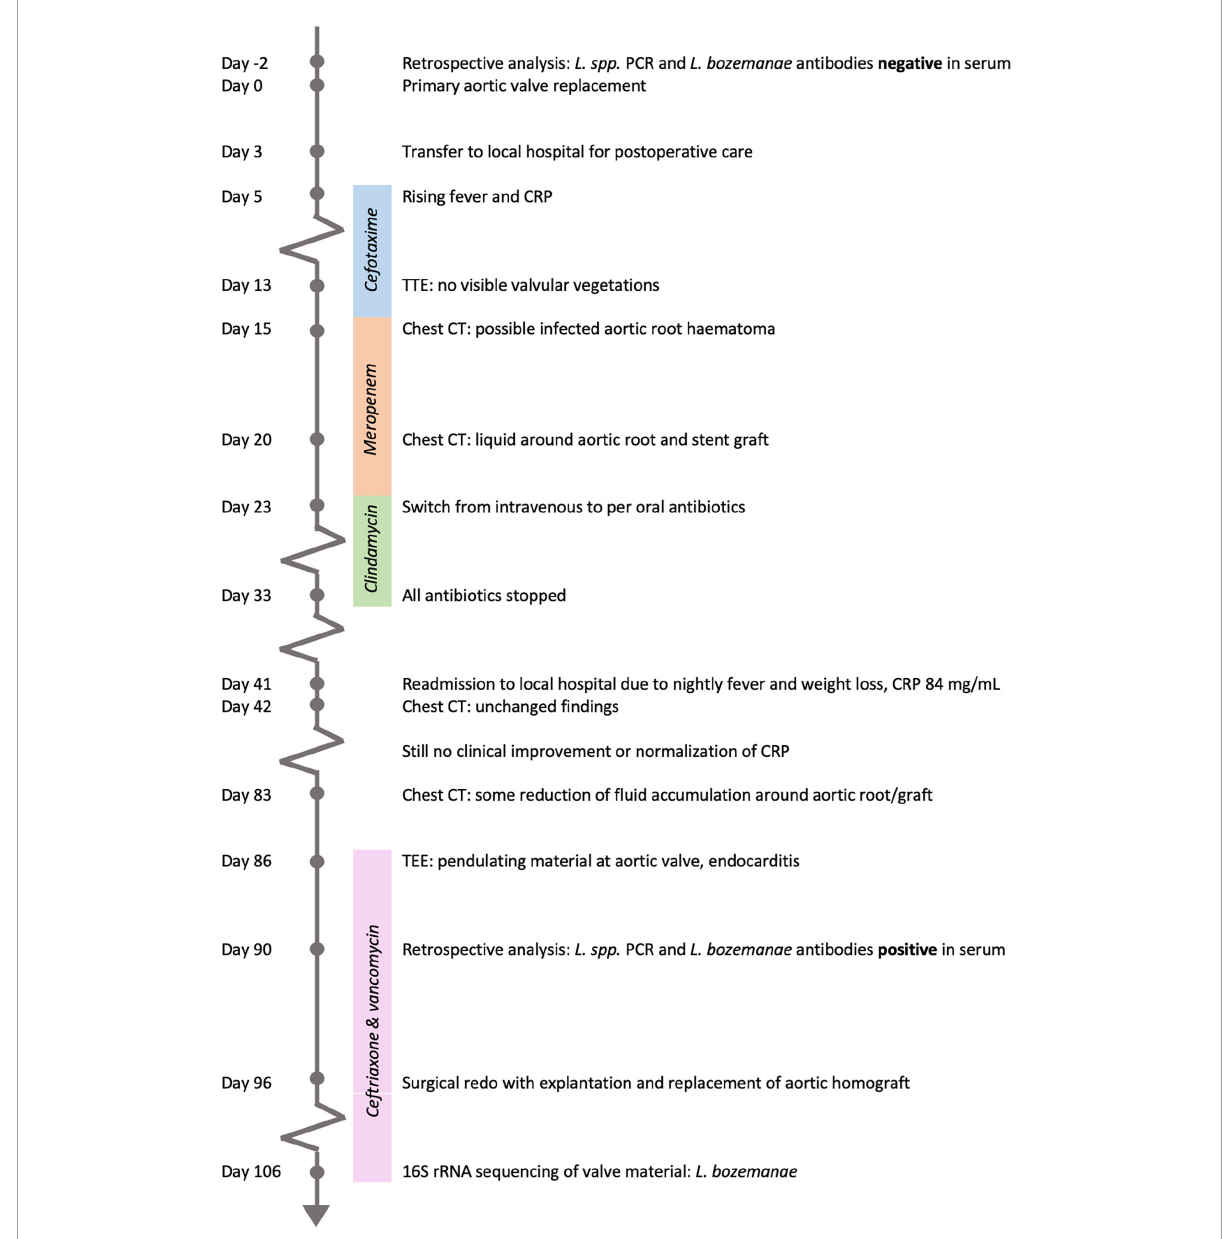
FIGURE1 Timeline from admission for the primary aortic valve replacement until microbial diagnosis by 16S rRNA sequencing of valve material.